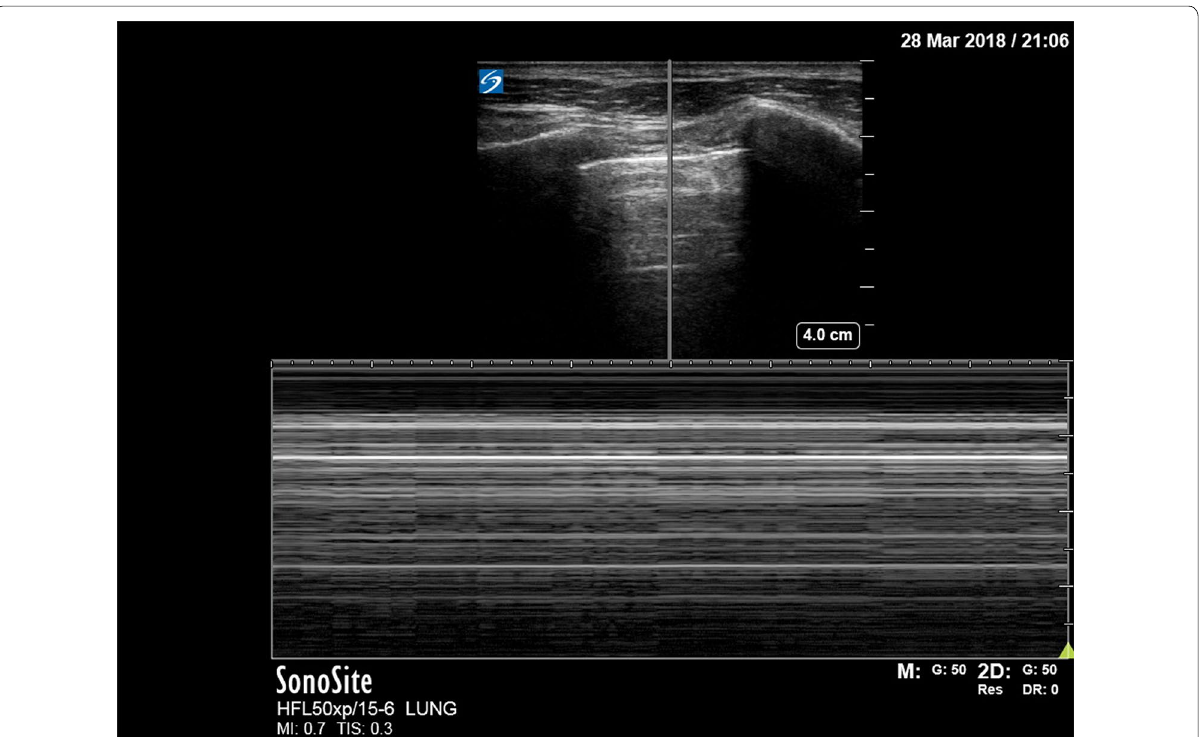
Fig. 5 Pneumothorax—M‑mode ultrasound image. There is no visible movement above or below the pleural line. Because all tissue and artifacts are stationary, the M‑mode image appears as horizontal straight lines throughout the image. This is called a barcode sign or stratosphere